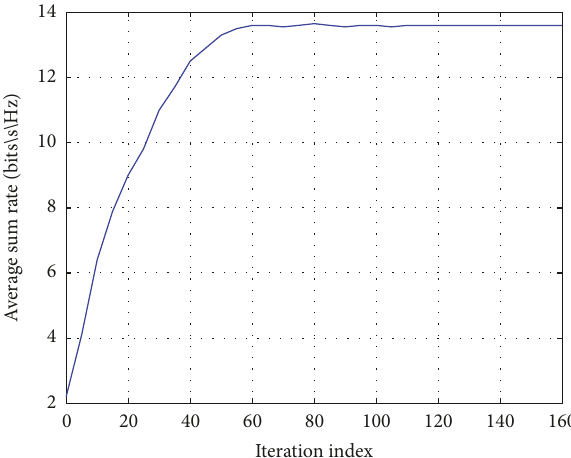
Figure 5: Operator’s profits versus different number of